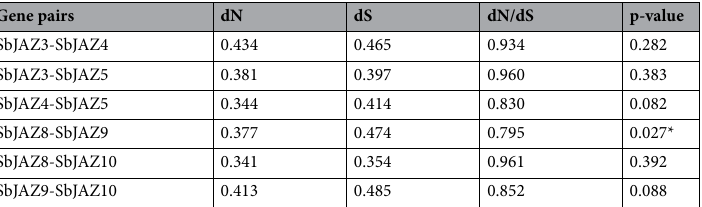
Table 2. Analysis of tandem duplication events of sorghum JAZ gene pairs. dN nonsynonymous substitutions rate, dS synonymous substitutions rate. To be considered purifying selection dN/ < 1 and p-value for the Z -test should be below 0.05 (*P < 0.05).